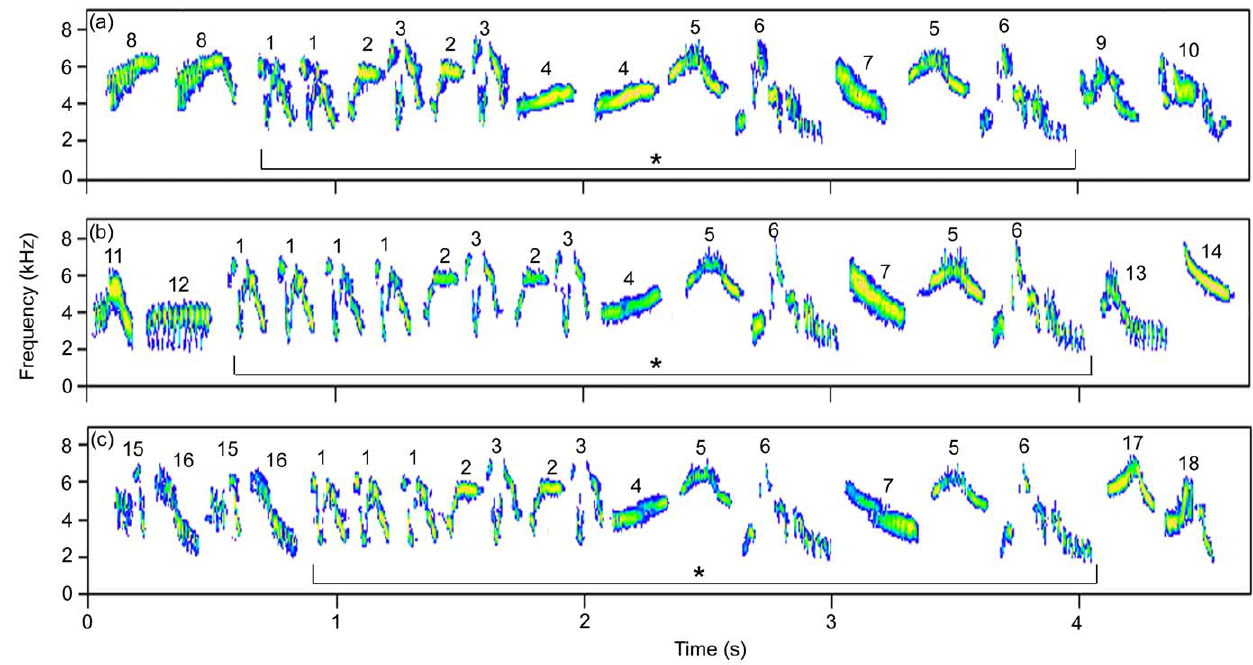
Figure 1. Sequence shared by members of the neighbourhood (microdialect). Spectrograms (FFT length, 256; frame, 100%; Hanning window) of song parts produced by an individual (ind a), his adjacent neighbour (ind b) and his distant neighbour (ind c) whose songs had been broadcast during the playback experiment, all including the same shared sequence (*). Syllables composing the shared sequence are labelled with numbers 1 to 7, and the other syllables with numbers 8 to 18.